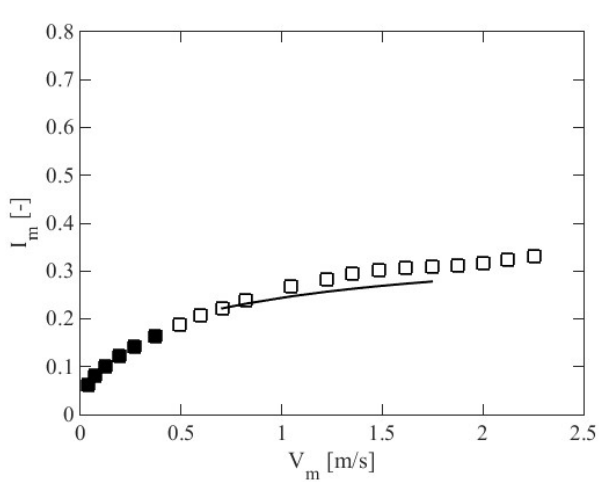
Fig. 5. Figure of hydraulic gradient predictions for run no. 2. Legend: filled squares – measured point in stationary bed, squares – measured points in sliding bed, continuous line – prediction .